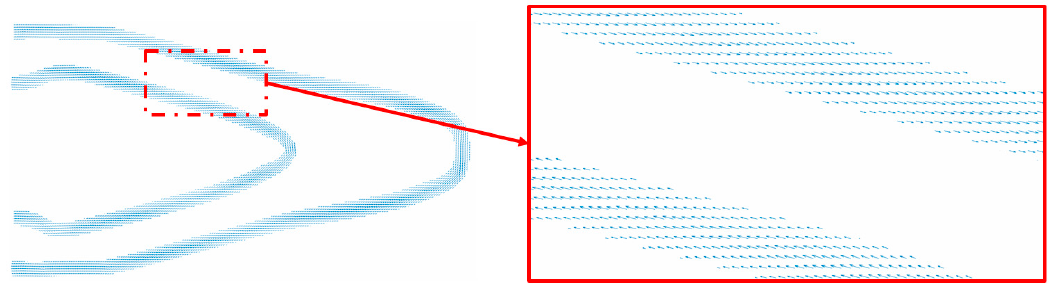
Figure 16. The boundary layer raster direction distribution.